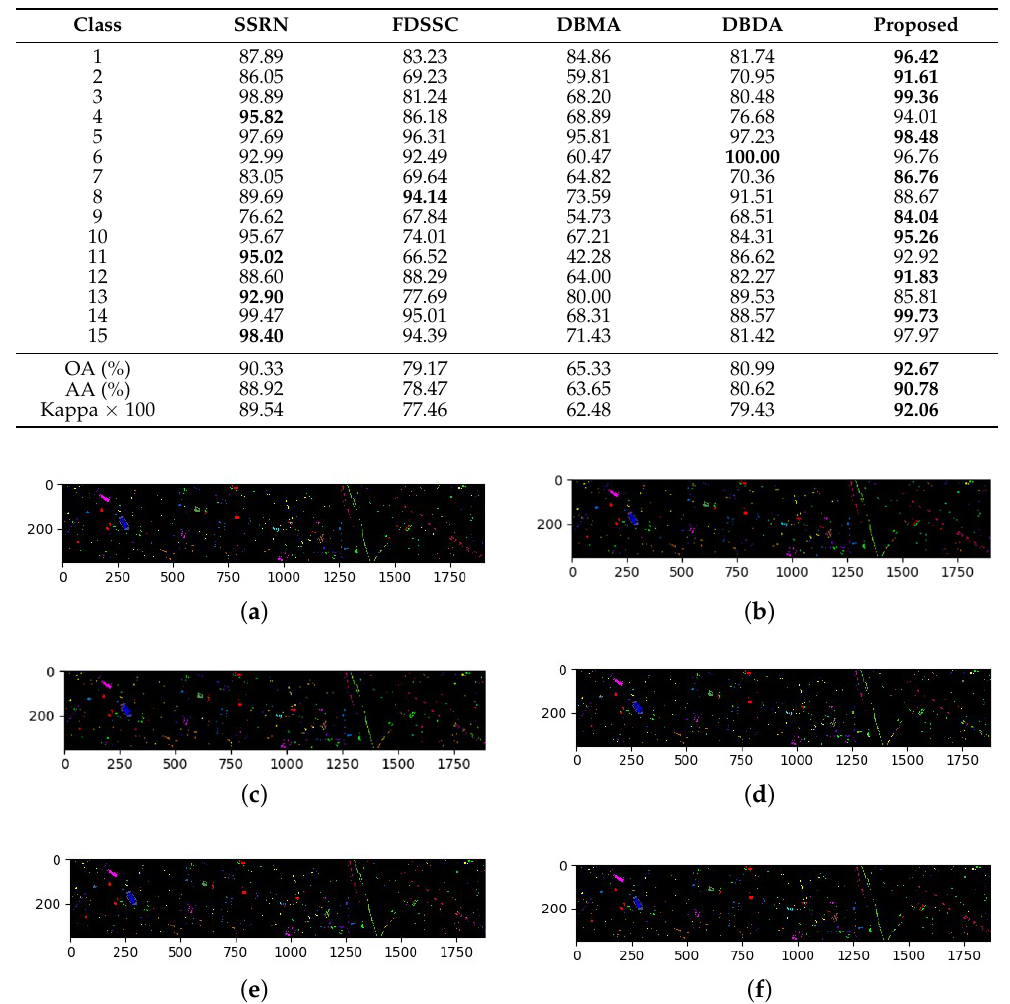
Table 9. Categorized results for the HS dataset.